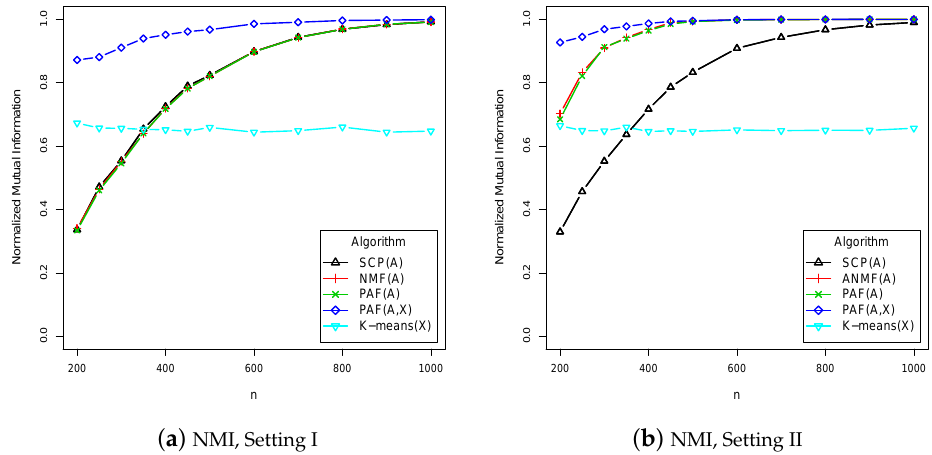
Figure 1. The two panels present the NMI results for Setting I (undirected SBM) and Setting II (directed SBM),